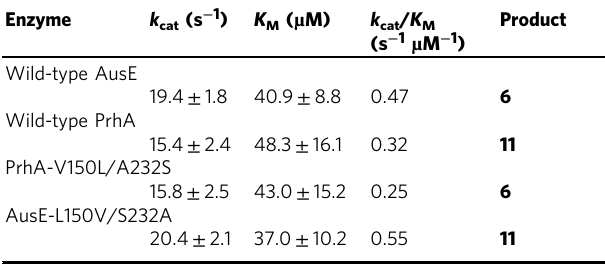
Table 1 The steady-state enzyme kinetics values of the wild- type and mutants of AusE and PrhA to preaustinoid A1 (5)